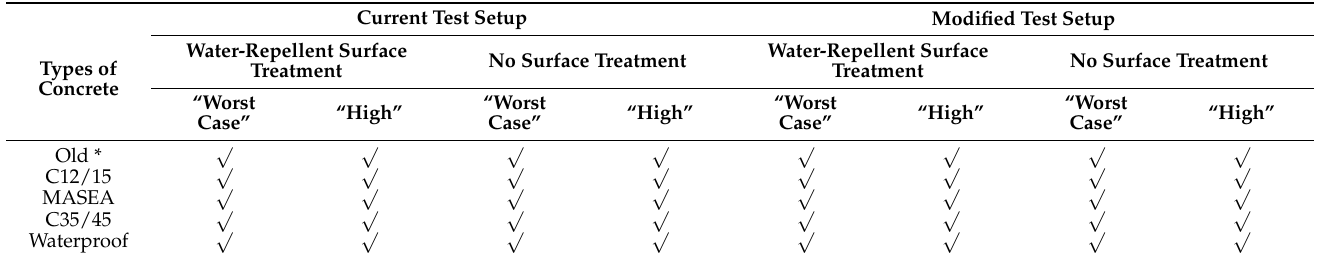
Table 3. Simulation